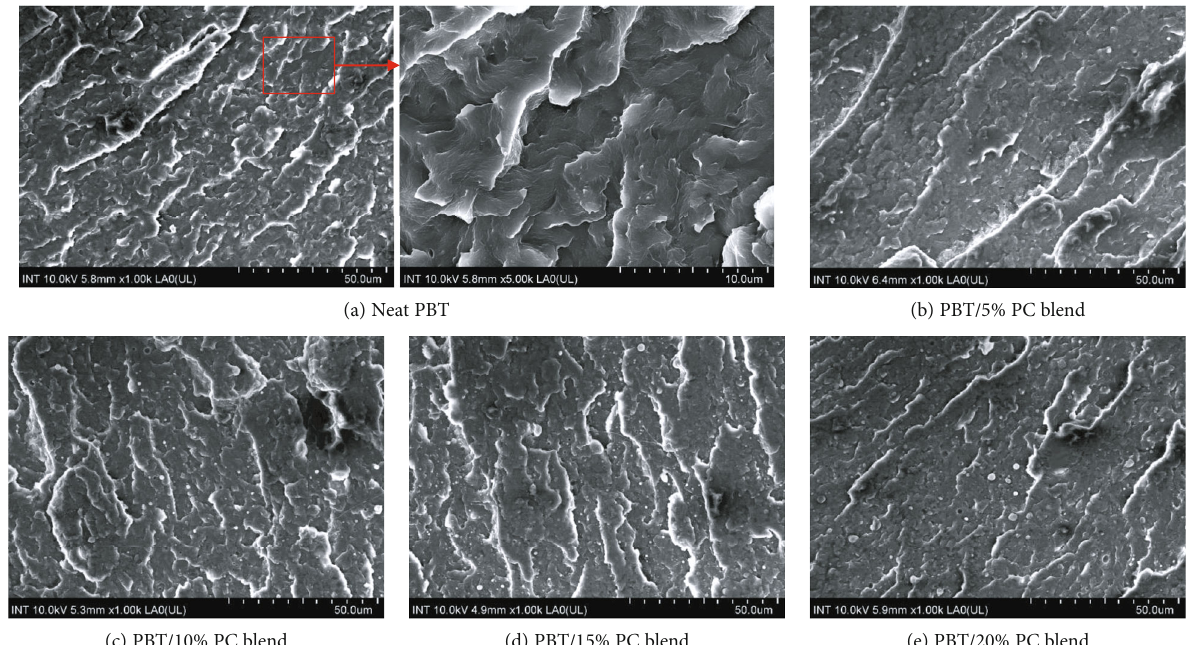
Figure 5: FESEM of fracture surface of PBT/PC blends.